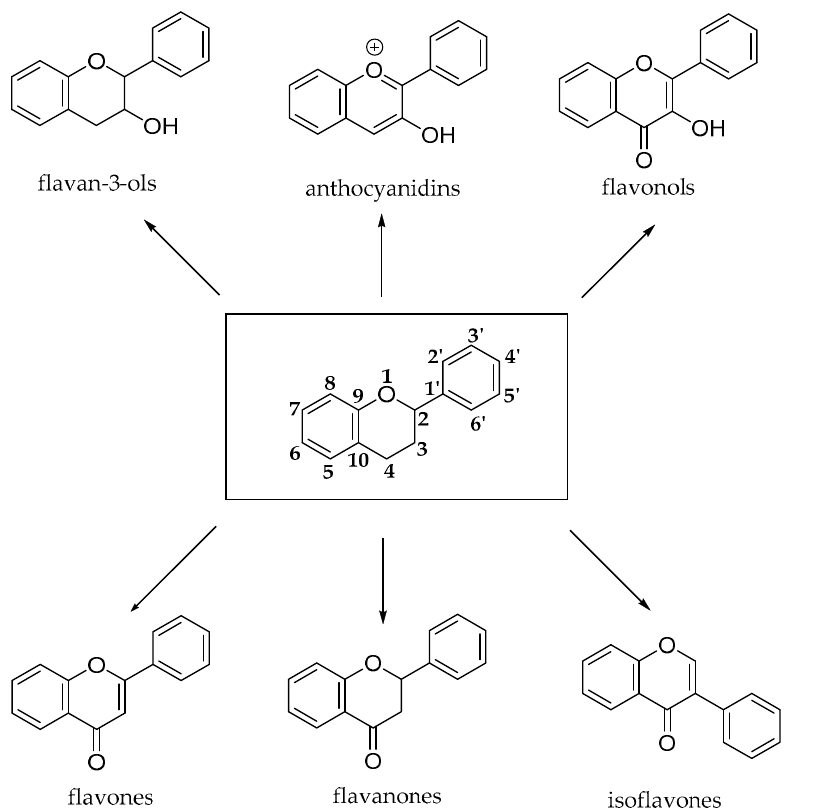
Figure 8. Basic structures of flavonoid subclasses.